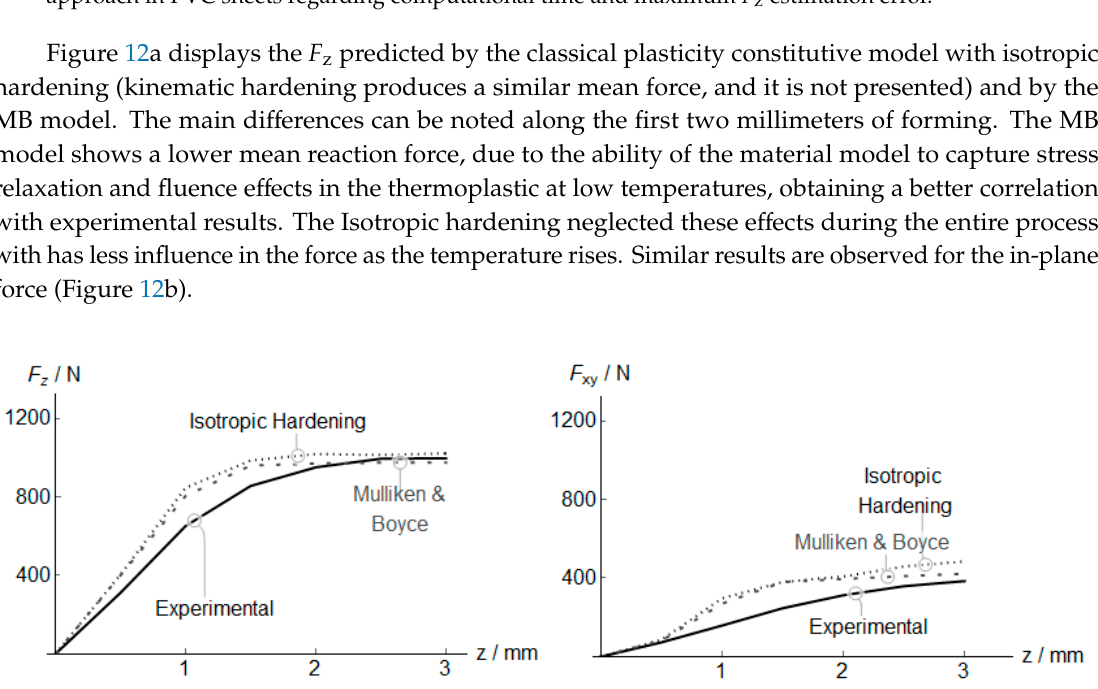
Figure 12. Mean force during PVC incremental forming at z positions. Vertical force ( a ), and in-plane force ( b ).